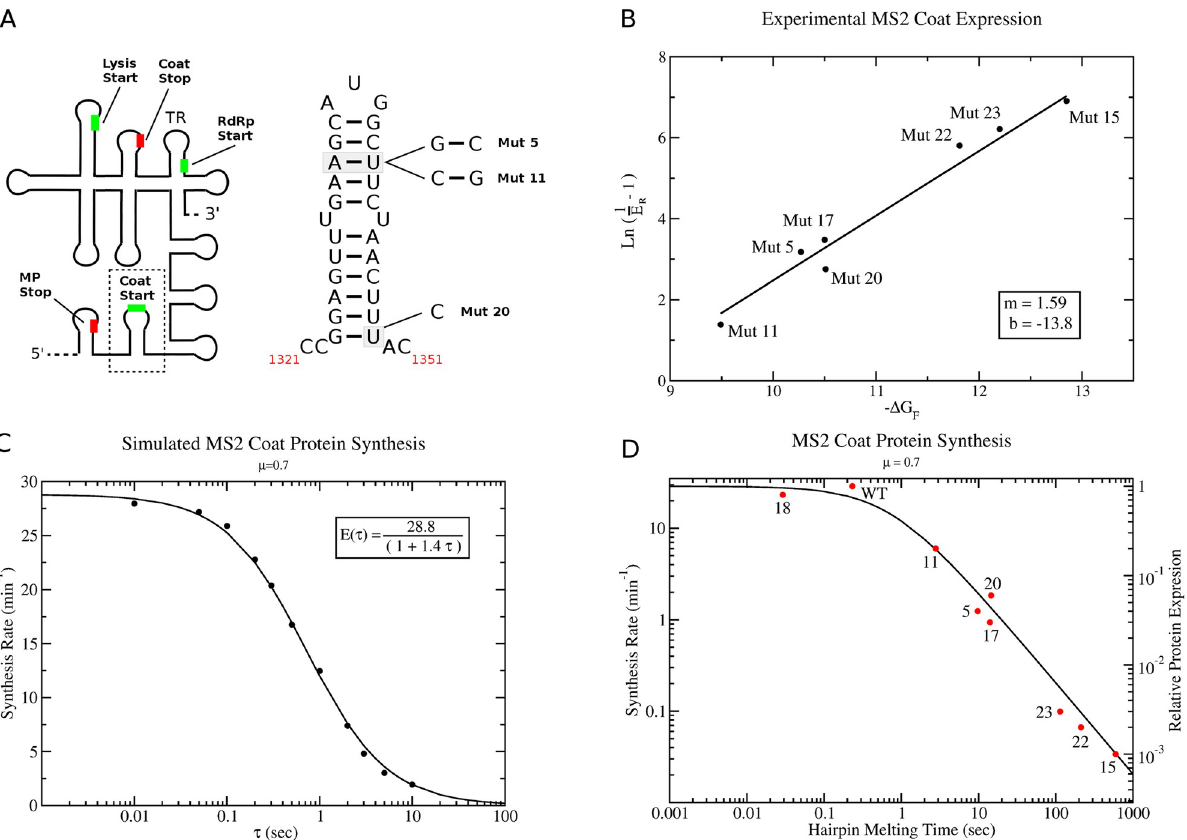
Fig 5. Coat protein expression in bacteriophage MS2 for different hairpin mutants. (A) Cartoon diagram of the secondary structure for the MS2 coat gene. Start codons for the various phage genes are indicated with a green bar, while stop codons are indicated with a red bar. The nucleotide sequence of the hairpin encompassing the coat gene start codon (dashed box in cartoon) is shown to the right. Mutants are labelled following [13]. (B) Best fit linear line of the experimental measurements from [13] to Eq 4. (C) Predicted MS2 coat protein synthesis rates are calculated from 30 min of ribosome kinetics at a growth rate of μ = 0.7 doublings per hour using hairpin unfolding times ranging from τ u = 0.01 to τ u = 10 seconds (black dots). The best fit of the data to the theoretical protein expression curve (Eq 2) is represented by the black line. (D) Fit of experimental relative coat protein expression data (red dots) to the theoretical expression curve (Eq